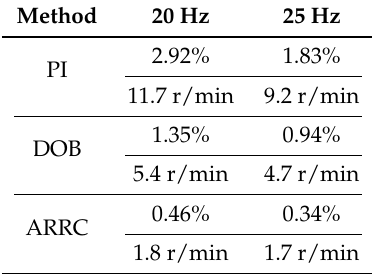
Table 4. Speed fluctuation ratio and its corresponding